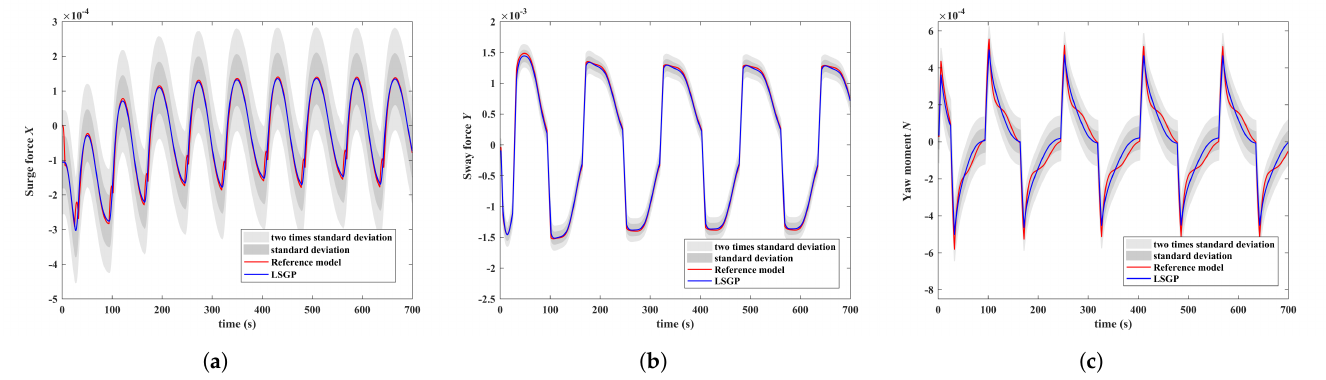
Figure 4. Comparison results of non-dimensional with the simulated ZZ-20 ◦ -10 ◦ test. ( a ) is about the Surge force of the “mariner”; ( b ) is about the Sway force of the ship; ( c ) is the situation of Yaw moment of the ship; the figure shows one and two times the standard deviation bandwidth